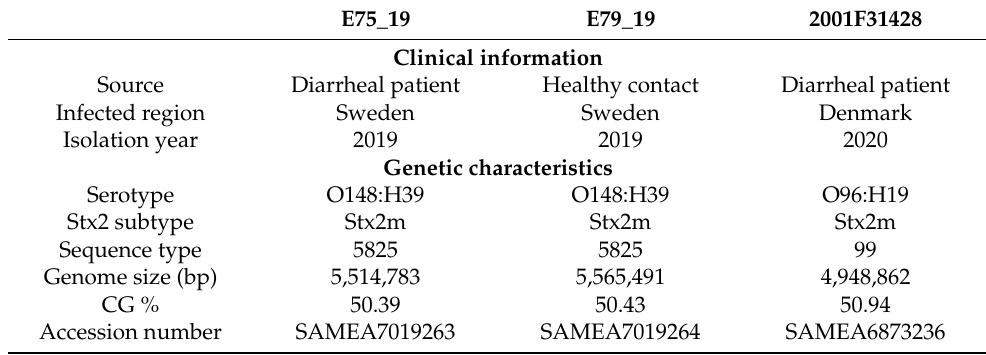
Table 1. Characterization of three Stx2m-producing STEC